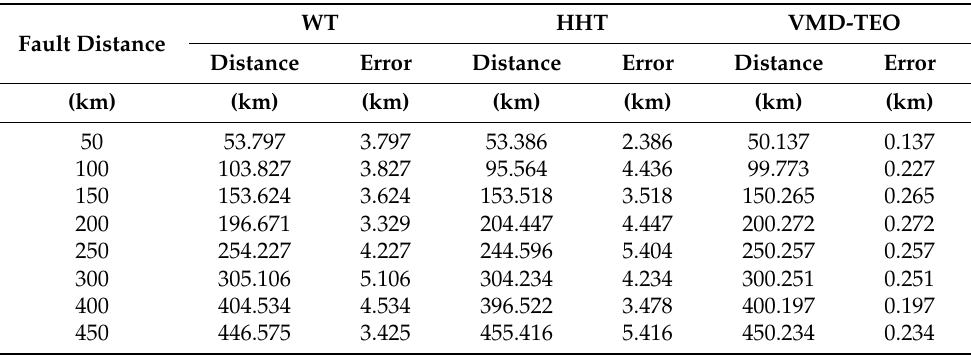
Figure 20. Testing results at different levels of noise. Table 2. Comparison of feature engineering